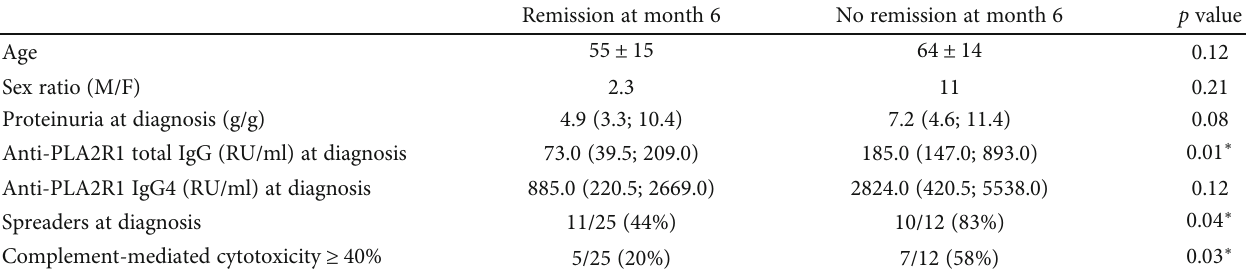
Table 3: Factors associated with remission at month 6 in patients treated with rituximab ( n = 37